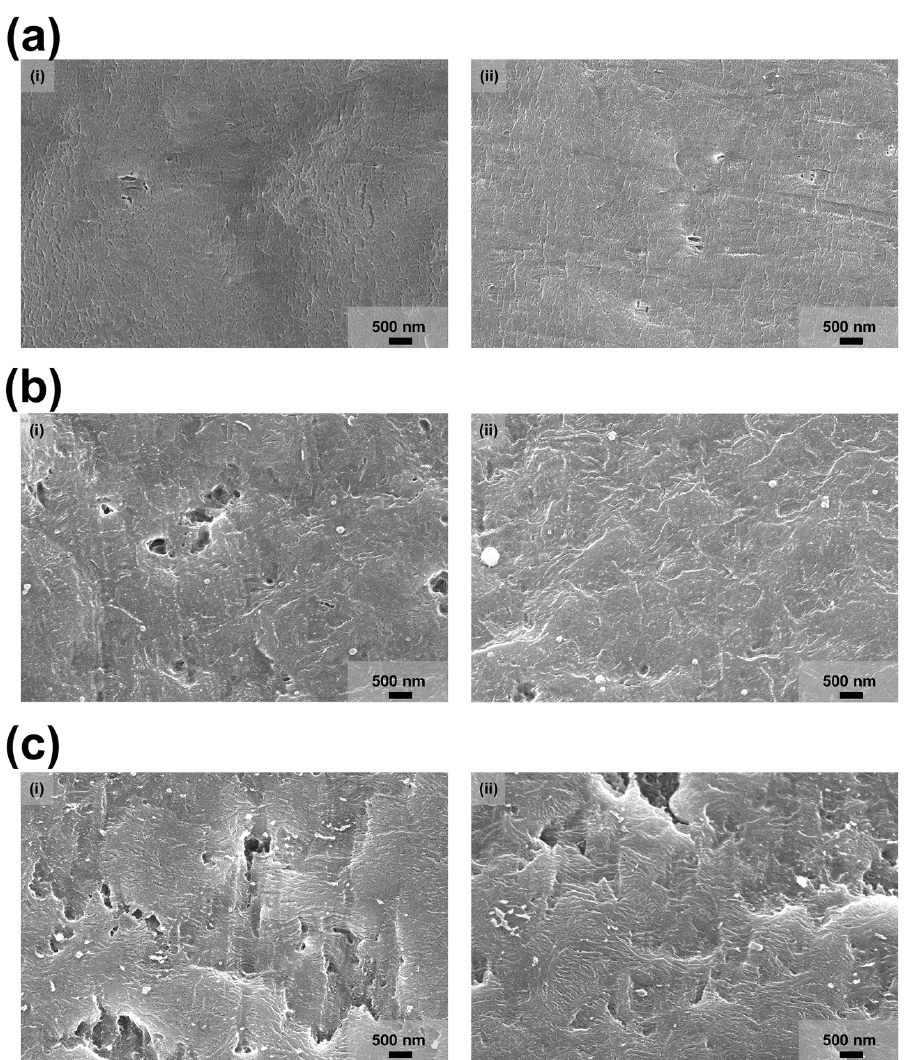
Figure 3. The surface of the PTFE film observed by the scanning electron microscope. ( a ) The surface of the bare PTFE film observed by the SEM with the tilted angle of the sample stage of ( i ) 0 ◦ and ( ii ) 15 ◦ . ( b )The surface of the PTFE film after conducting the tilted reactive ion etching with the tilted angle of 0 ◦ by the SEM with the tilted angle of the sample stage of ( i ) 0 ◦ and ( ii ) 15 ◦ . ( c ) The surface of the PTFE film after tilted reactive ion etching with the tilted angle of 60 ◦ observed by the SEM with the tilted angle of the sample stage of ( i ) 0 ◦ and ( ii ) 15 ◦ ,